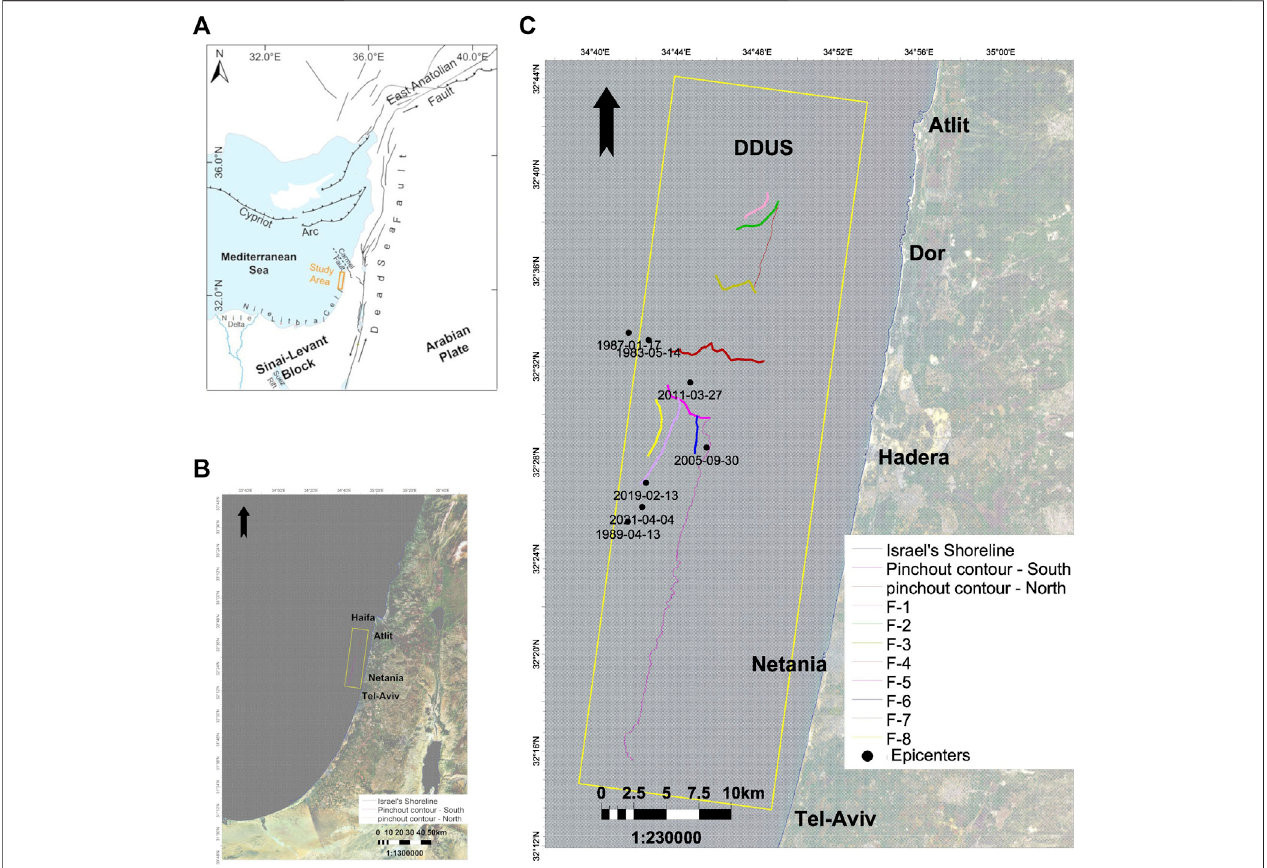
FIGURE 1 | Location map: (A) Regional faults map — after (Barnea Cohen et al., 2022); (B) Regional map; (C) Slumps and scars — after (Gadol et al., 2020) and faults in study area.